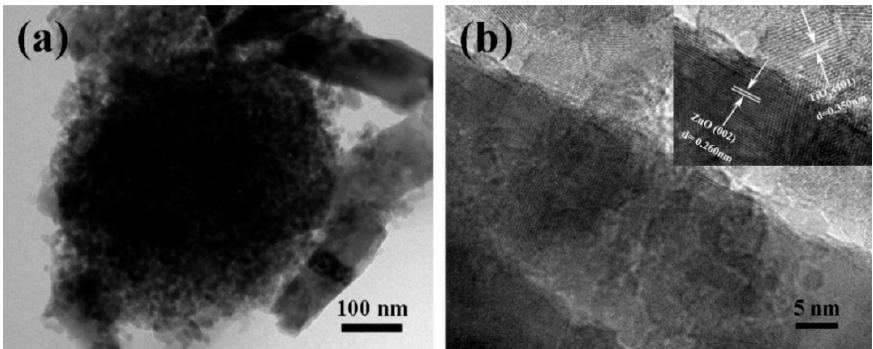
Figure 2. Structural characterizations of ZnO NRs/TiO 2-X MSs: ( a ) TEM image of ZnO NRs/TiO 2-X MSs; ( b ) HRTEM image of ZnO NRs/TiO 2-X MSs.